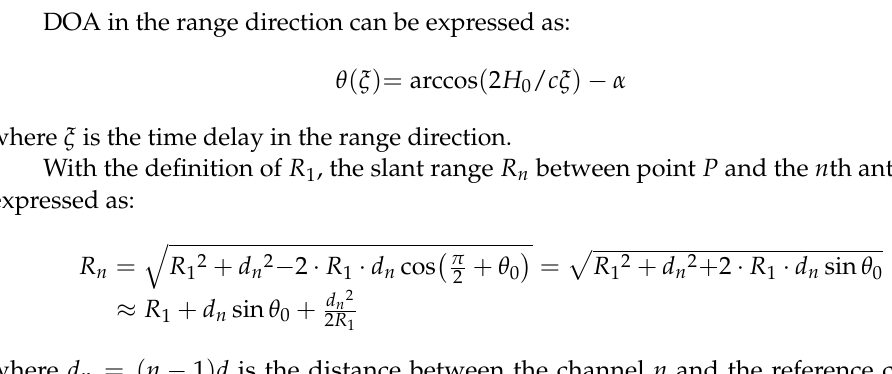
H is the height of the reference channel,  , 0 channel and the point P , and